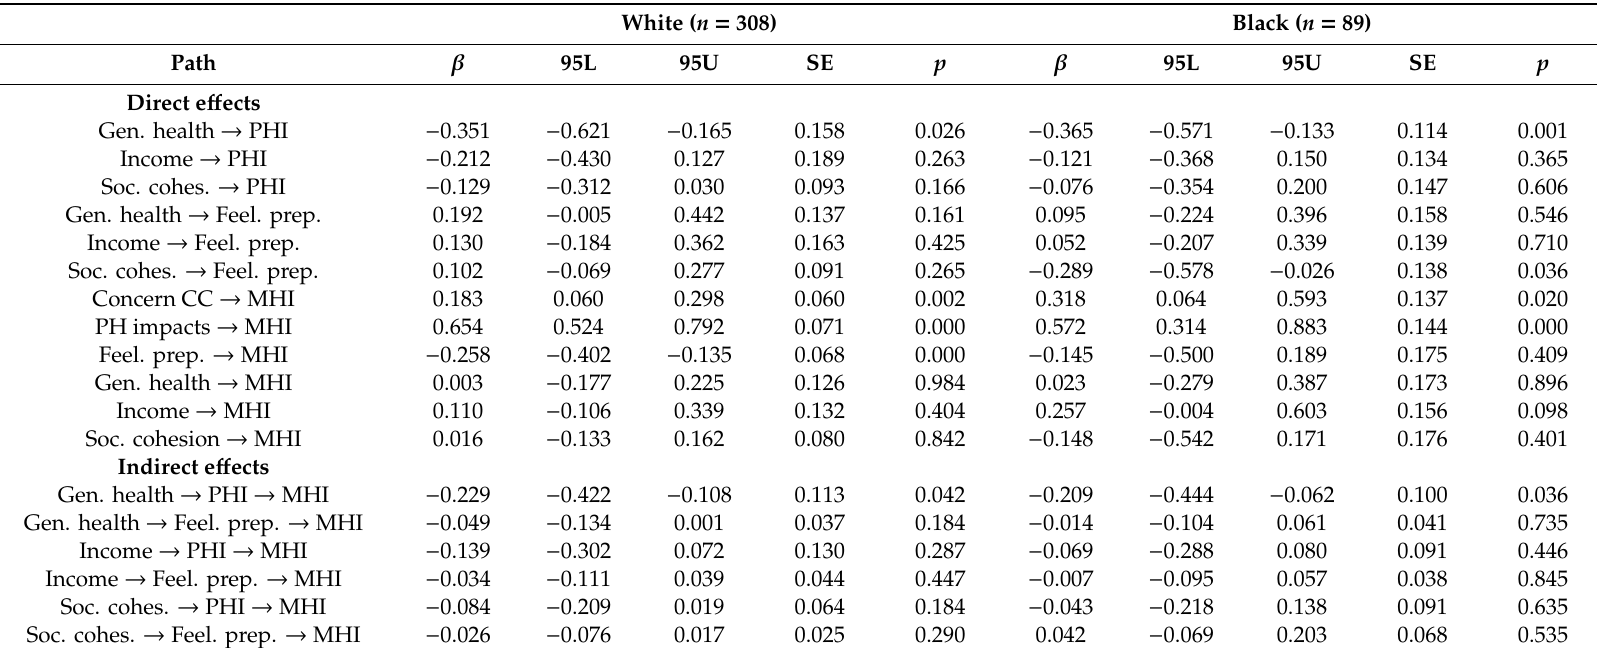
Table 8. Path analysis results for winter extremes, by subgroup (N = 397).